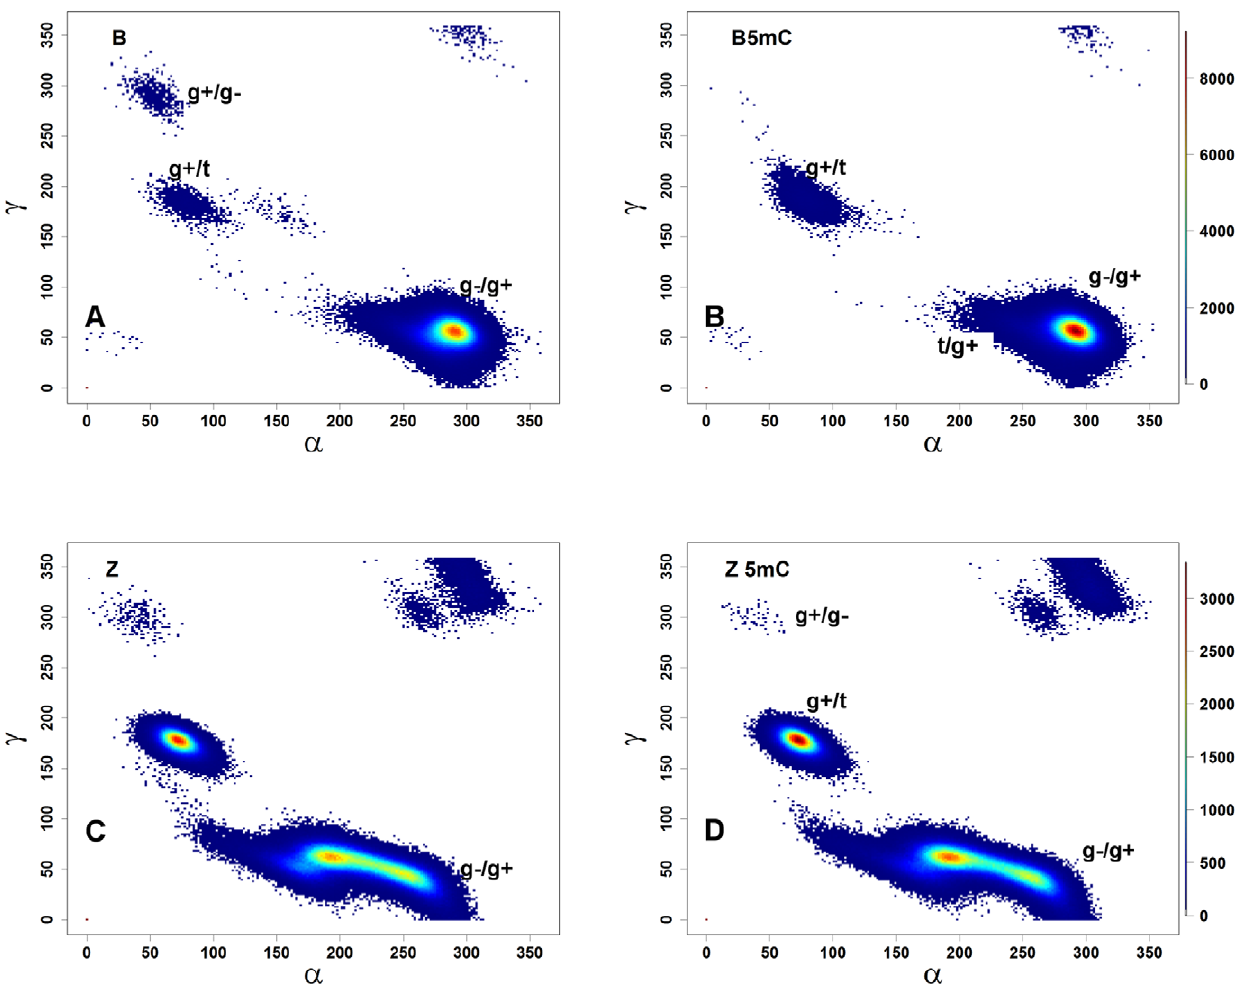
Figure 5. The a / c distributions in B- and Z-DNA. Landscape of the combined distributions of phosphate torsion angles along the a / c space. (A) B-DNA; (B) 5mCB-DNA; (C) Z-DNA; (D) 5mCZ-DNA. The plots are color-coded based on the density of points. The results from the two independent simulations for each state are combined, giving 1.6 million points. The color bars on panels B and D show the density values for B- (panels A and B) and Z-DNA (panels C and D)